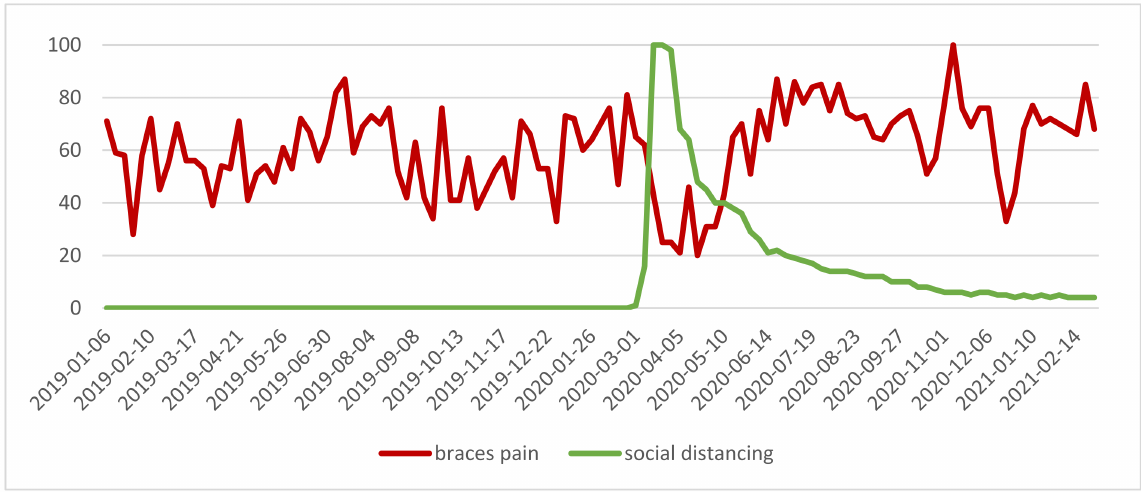
Figure 4. “braces pain” and “social distancing” phrases—relative search